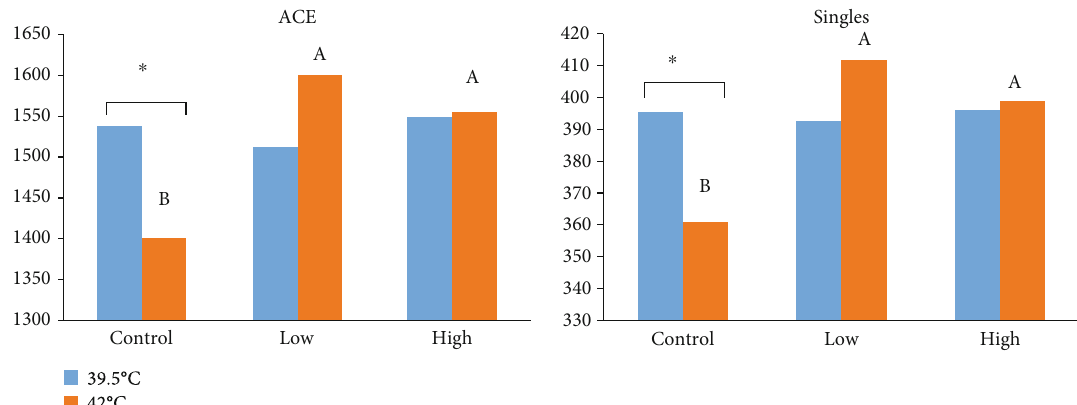
Figure 4: Diversity parameters of ruminal archaea in solid phase as a ff ected by betaine addition 1 and temperature. Di ff erent superscripts on heat stress (42 ° C) bars represent signi fi cant di ff erence ( P < 0 : 05 ). ∗ P < 0 : 05 . 1 Betaine levels: control (0), low (51), and high (286)